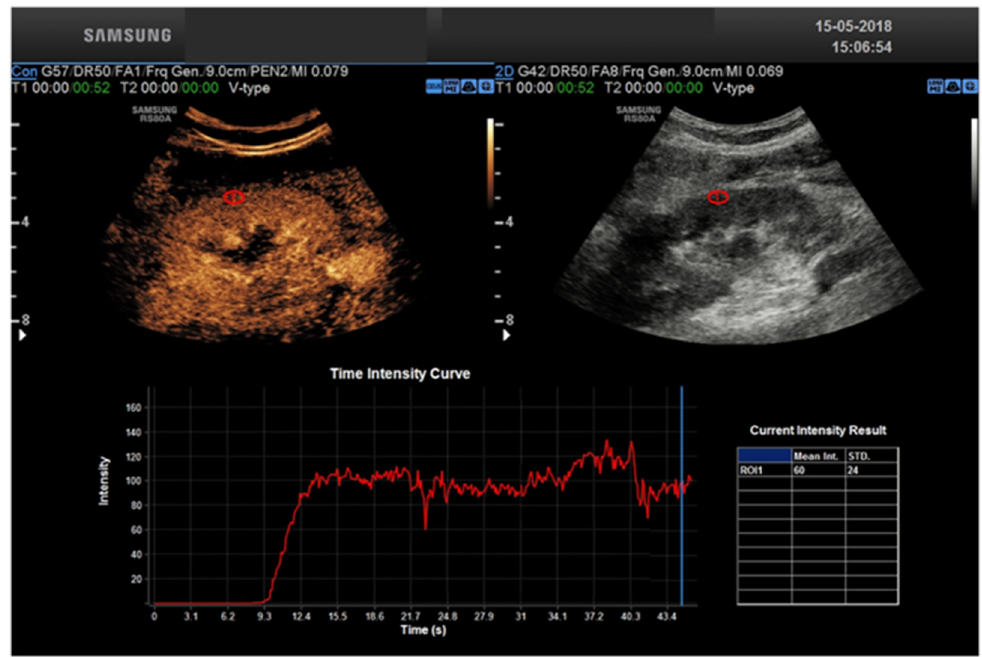
Figure 2. Healthy kidney TIC.